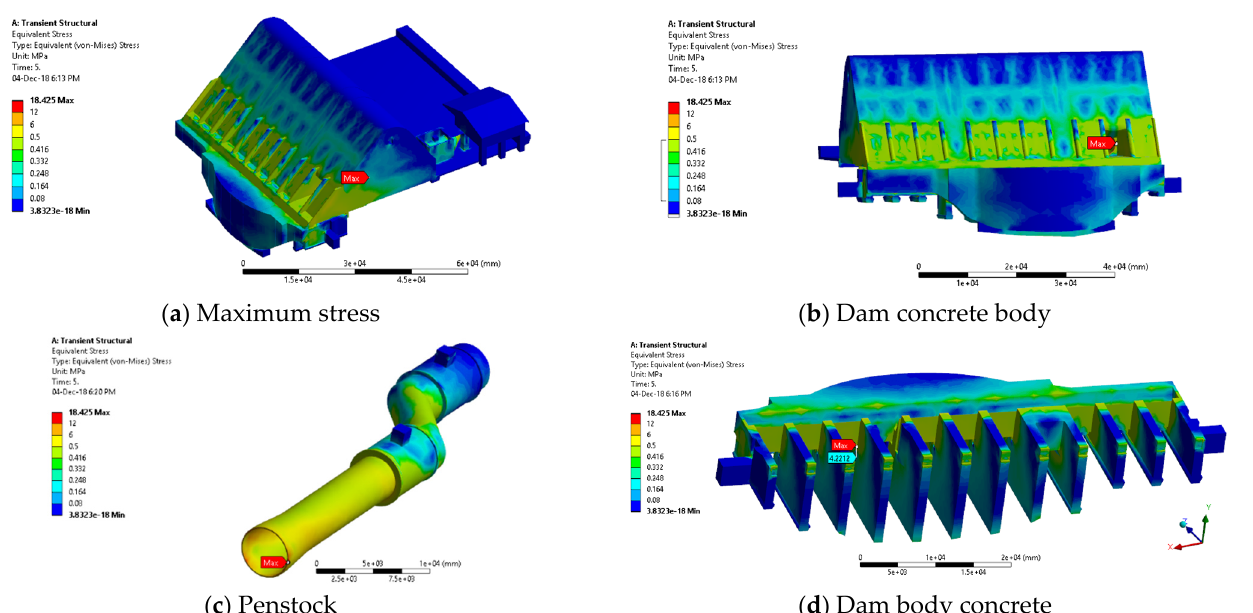
Figure 13. Bottom outlet operates at Case 2.